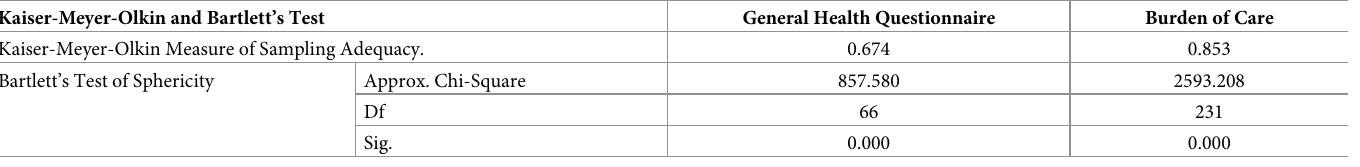
Table 5. KMO and Bartlett’s Test on the General Health Questionnaire 12 and the burden of care. Kaiser-Meyer-Olkin and Bartlett’s